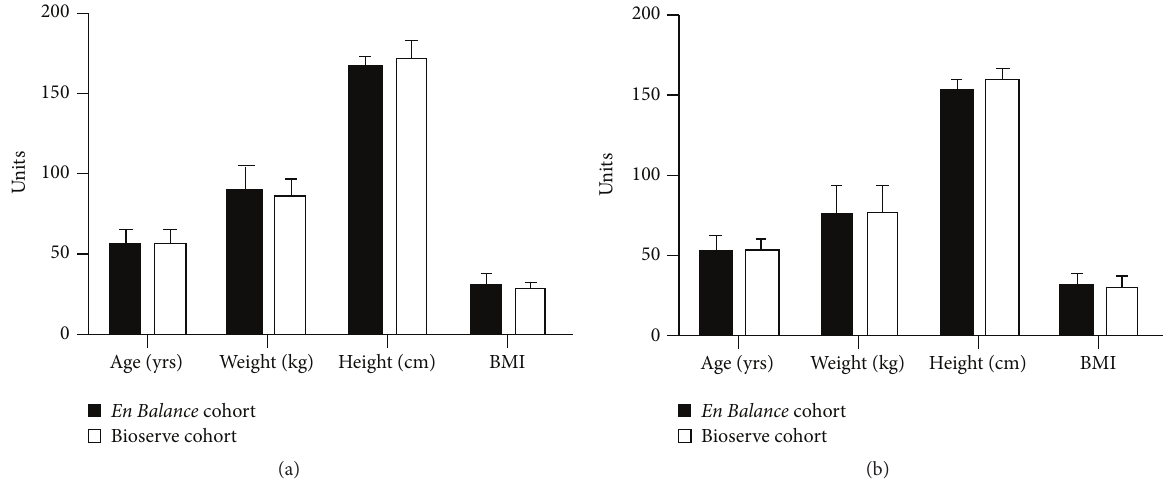
Figure 1: Basic patient characteristics between the En Balance and Bioserve cohorts do not differ. (a) Comparison of patient characteristics of male serum donors. Bar graph includes data from all En Balance samples (including the 21 samples for which the Bioserve samples were matched) and Bioserve samples. (b) Comparison of patient characteristics of female serum donors. Bar graph includes data from all En Balance samples (including the 21 samples for which the Bioserve samples were matched) and Bioserve samples.